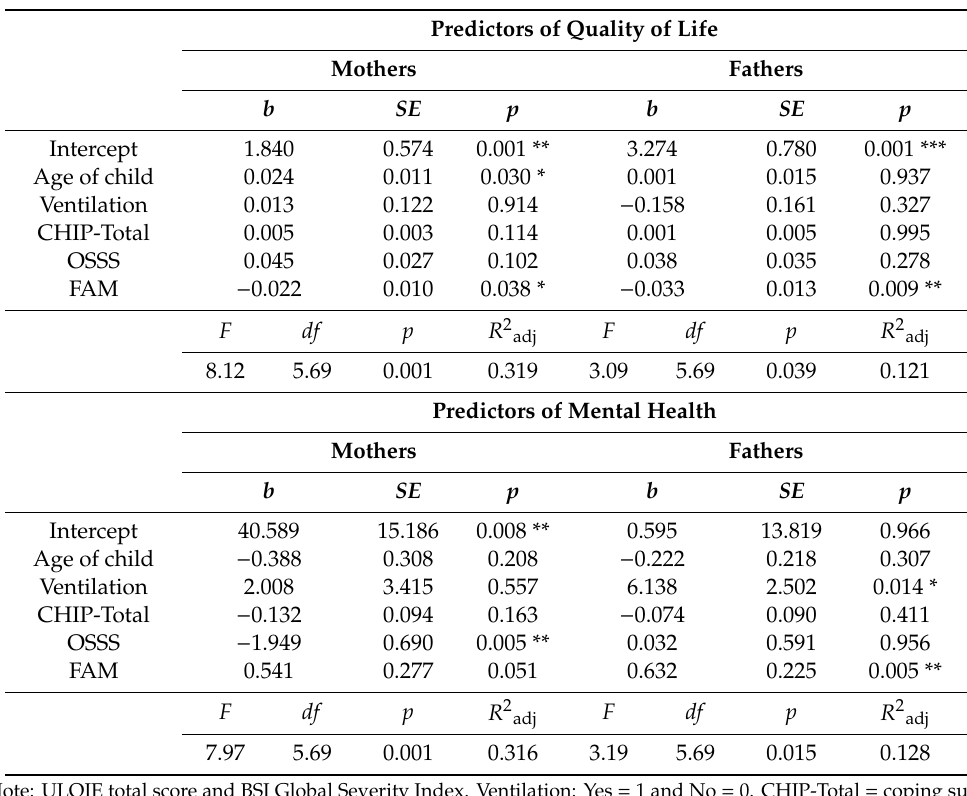
Table 6. Predictors of quality of life and mental health in mothers and